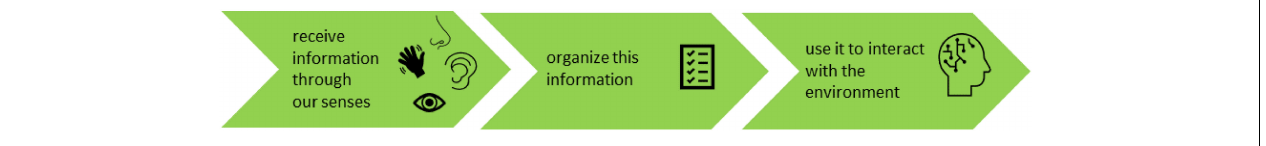
FIGURE 4 | Main aspects of sensory integration.